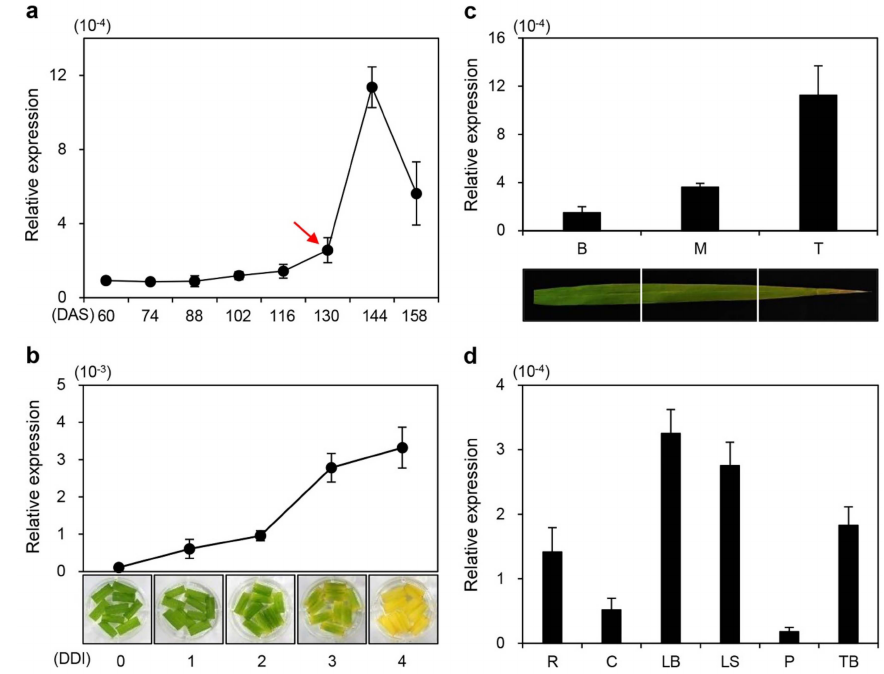
Figure 1. Expression profiles of ONAC096 . ( a – c ) ONAC096 transcript levels were measured in the leaves of wild-type (WT) plants grown in the field under natural long-day (NLD) conditions ( ≥ 14 h light per day) ( a,c ) or in detached leaves of WT plants grown in a growth chamber for 3 weeks under long-day (LD) conditions (14 h light / 10 h dark) ( b ). ( a ) ONAC096 is strongly expressed in WT flag leaves after heading. The red arrow indicates the heading date (130 days after seeding (DAS)). ( b ) ONAC096 expression gradually increases in detached leaves of 4-week-old WT plants in which senescence was induced in complete darkness in 3 mM MES buffer (pH 5.8) at 28 ◦ C. ( c ) ONAC096 transcript levels in senescing WT flag leaves that were divided into three regions at the ripening stage (158 DAS). B, bottom; M, middle; T, tip. ( d ) ONAC096 is differentially expressed in WT tissues separated from the tiller base (TB) at the tillering stage (88 DAS) in root (R), culm (C), leaf blade (LB), leaf sheath (LS), and panicle (P) tissue at the heading stage (130